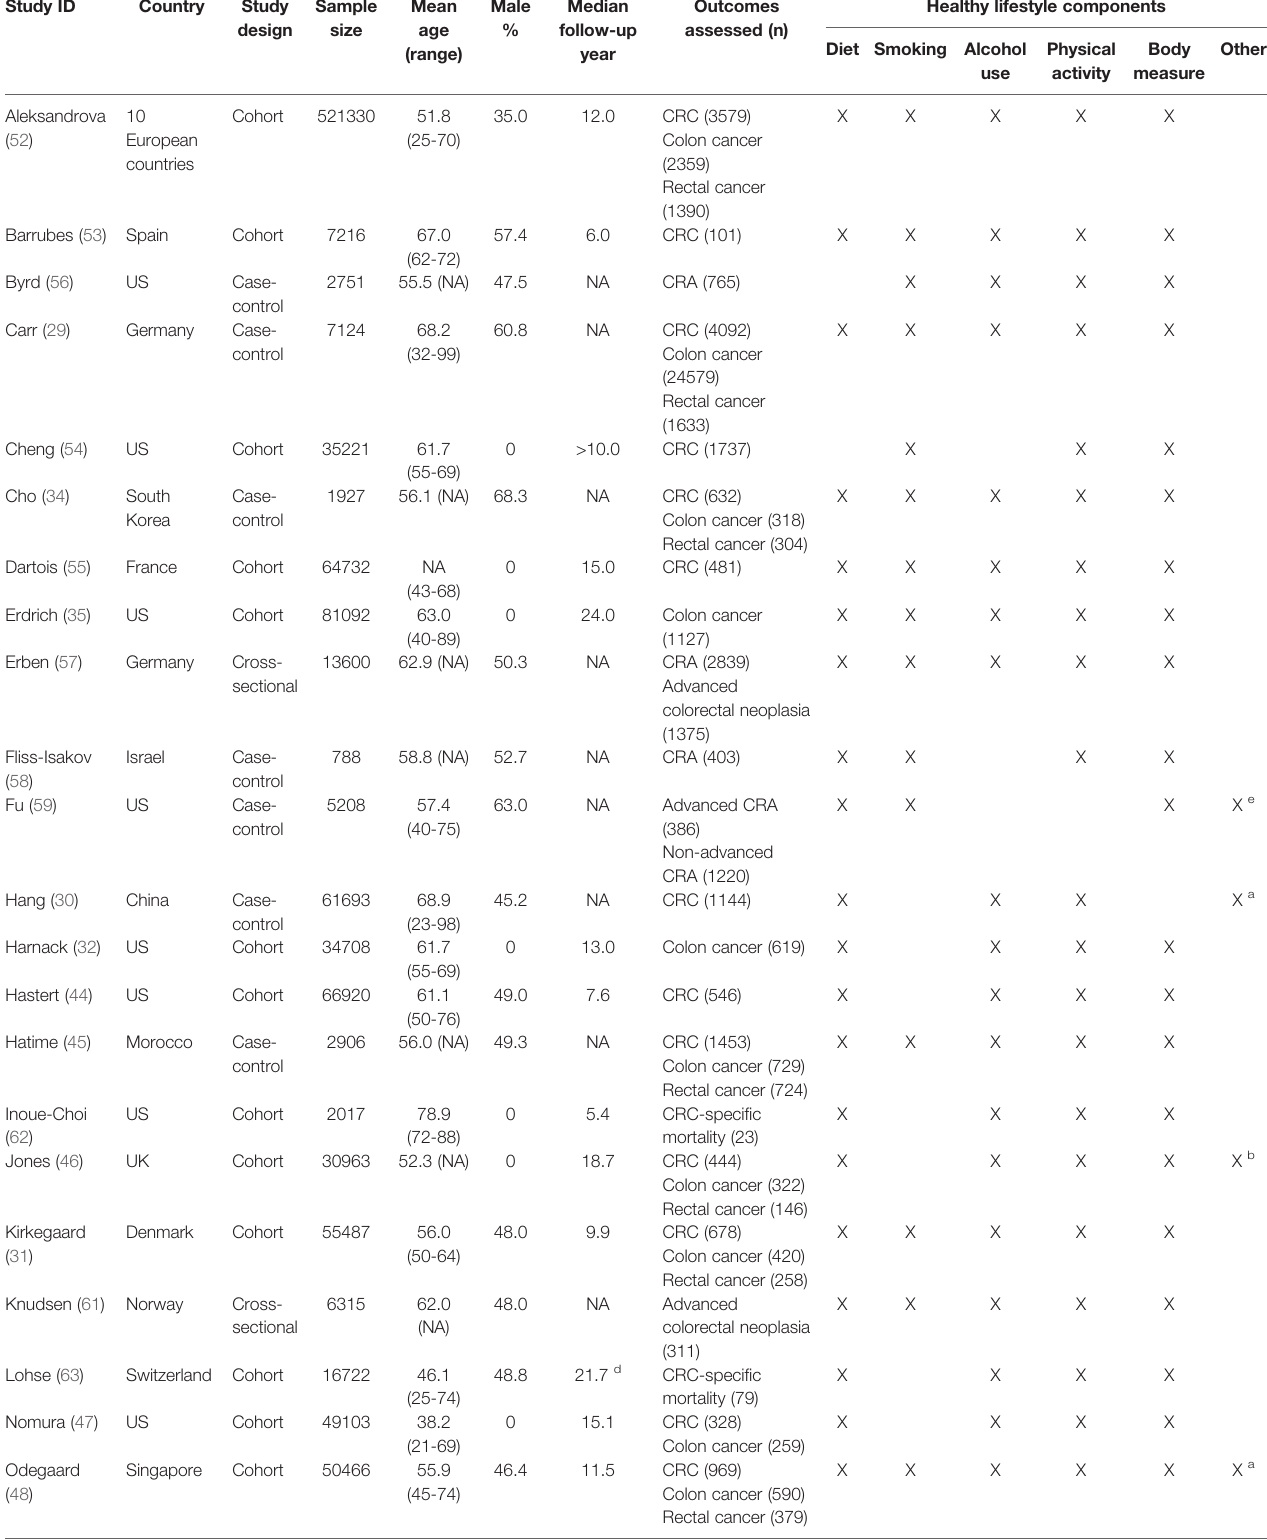
TABLE 1 | Basic characteristics of the included studies